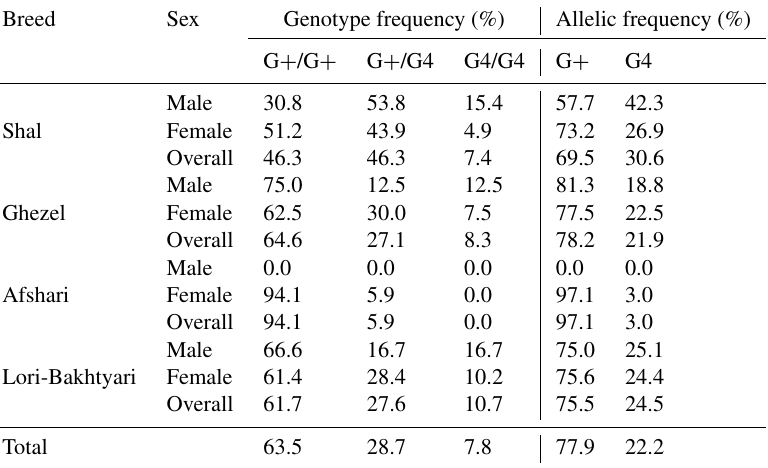
Table 5. Allelic and genotypic frequencies of the GDF9 G4 mutation (G721A) in Iranian Shal, Ghezel, Afshari, and Lori-Bakhtiari sheep